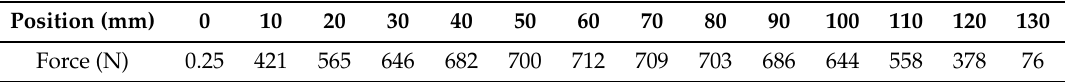
Table 2. Force on the plunger depending on its position with a coil current equal to 100 A.